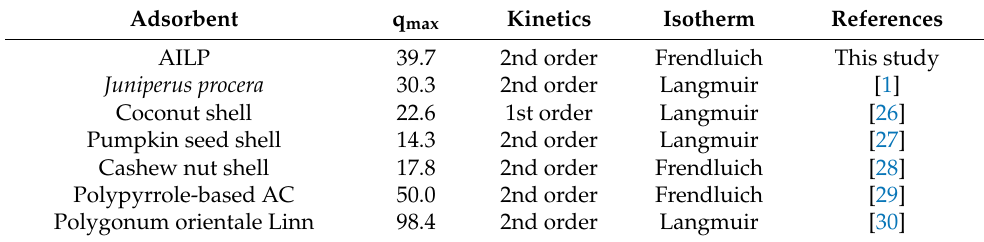
Table 5. Comparison of AILP and other